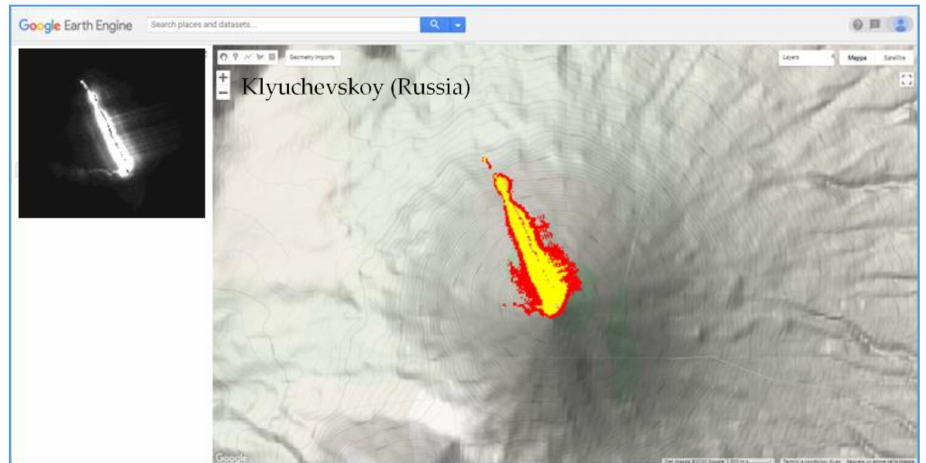
Figure 7. Thermal anomaly map from ASTER data of 29 May 2007 at 10:56 UTC. On the left top, shortwave infrared (SWIR2) band 5